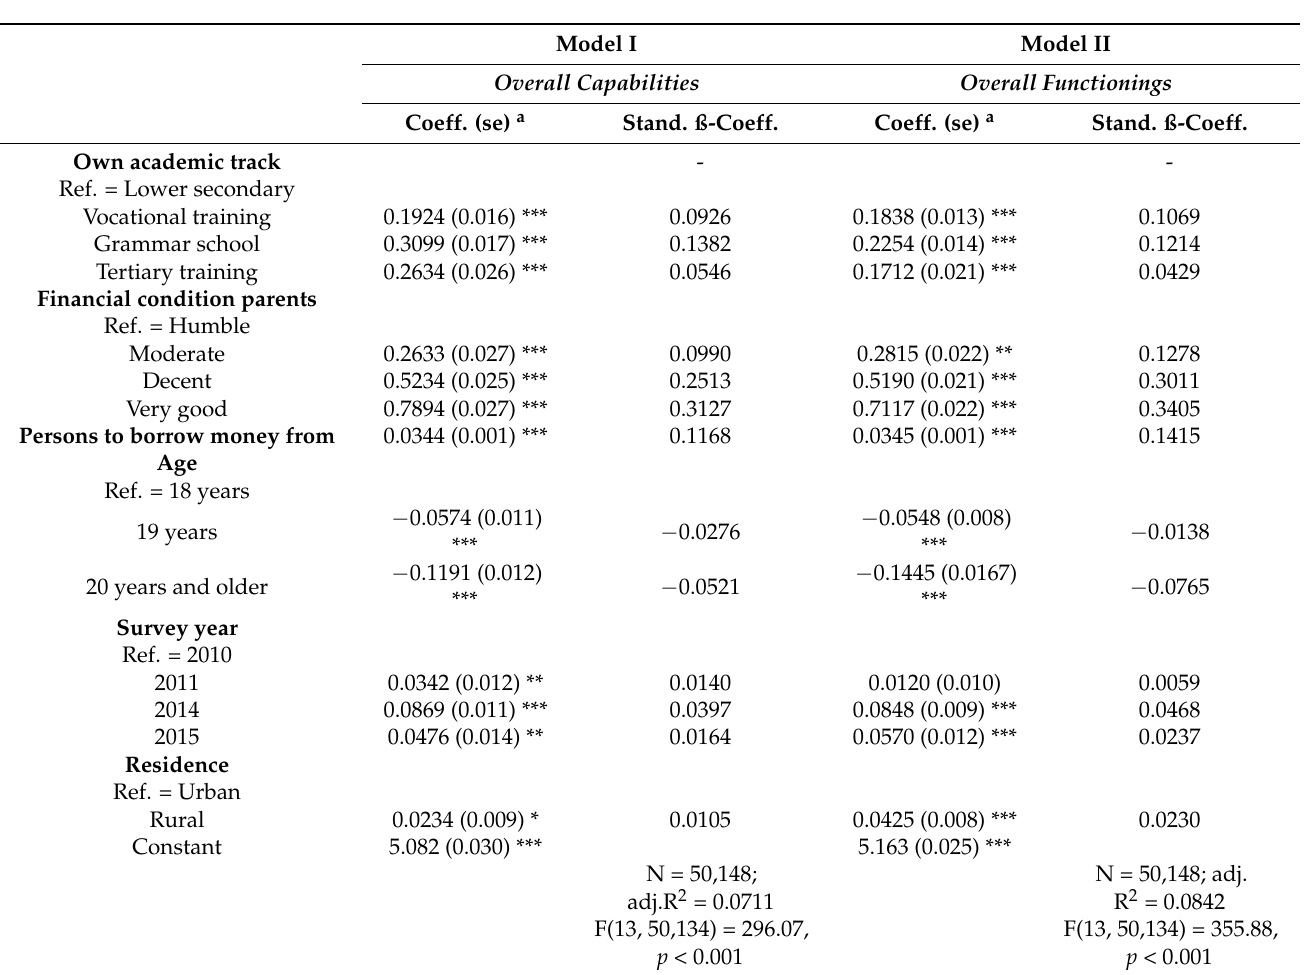
Table 4. Multivariate regression analysis on overall capabilities (model1) and overall functionings (model 2). Model I Model II Overall Capabilities Overall Functionings Coeff. (se) a Stand. ß-Coeff. Coeff. (se) a Stand.